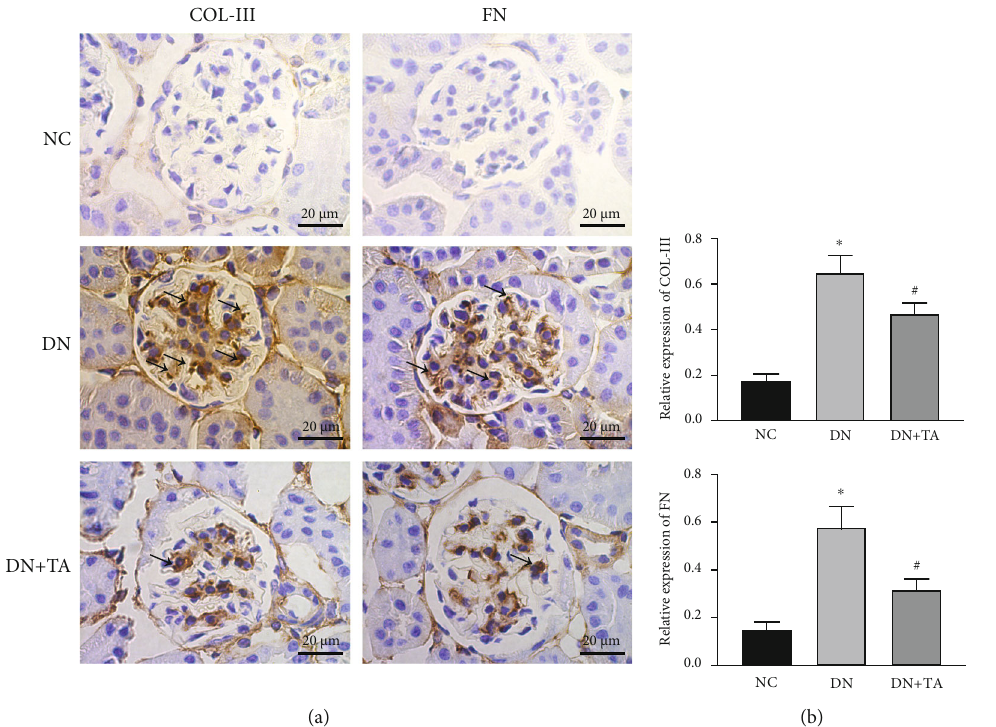
Figure 7: TA administration reduced renal fi brosis in DN. (a) Immunohistochemistry of COL-III and FN. Original magni fi cation 400x. (b) Semiquantitative analyzation of COL-III and FN expressions. The arrows in the kidney section indicate that COL-III and FN are highly expressed areas. Data were expressed as mean ± SD ( n = 10 ). ∗ P < 0 : 05 versus NC group; # P < 0 : 05 versus DN